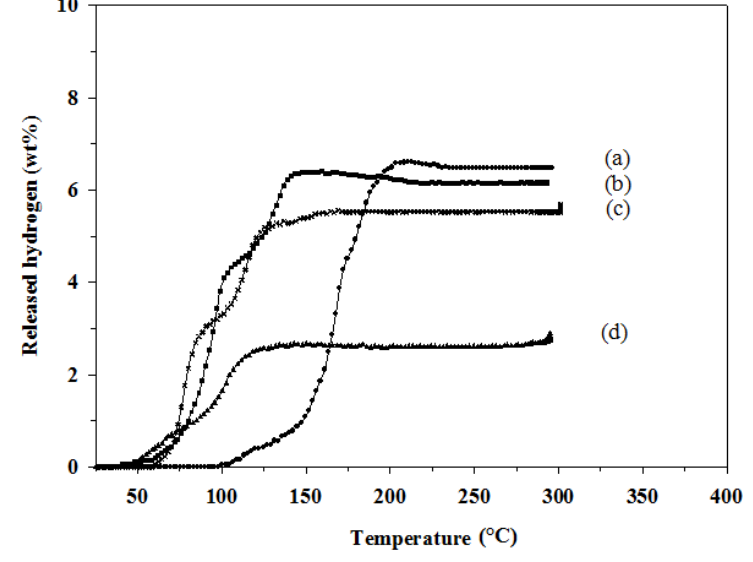
Figure 3. Hydrogen desorption profiles of: ( a ) 2LiAlH TiCl –2LiAlH 3 –2LiAlH TiCl 3